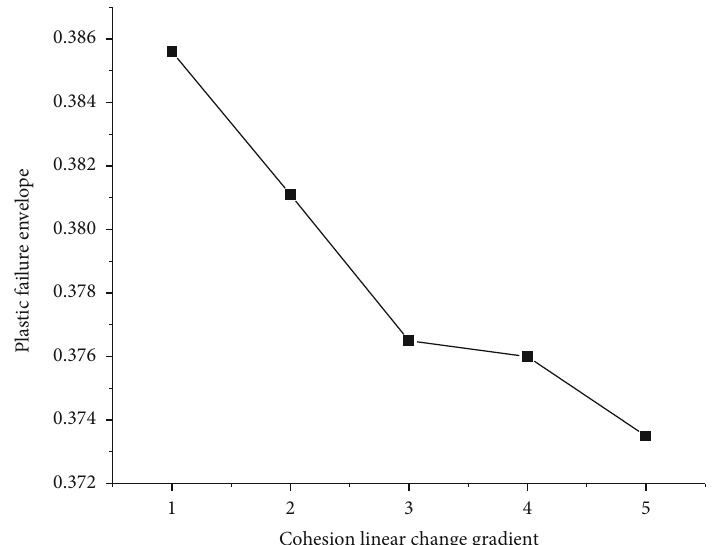
Figure 9: Failure envelopes of soil under di ff erent nonhomogeneity parameters λ .